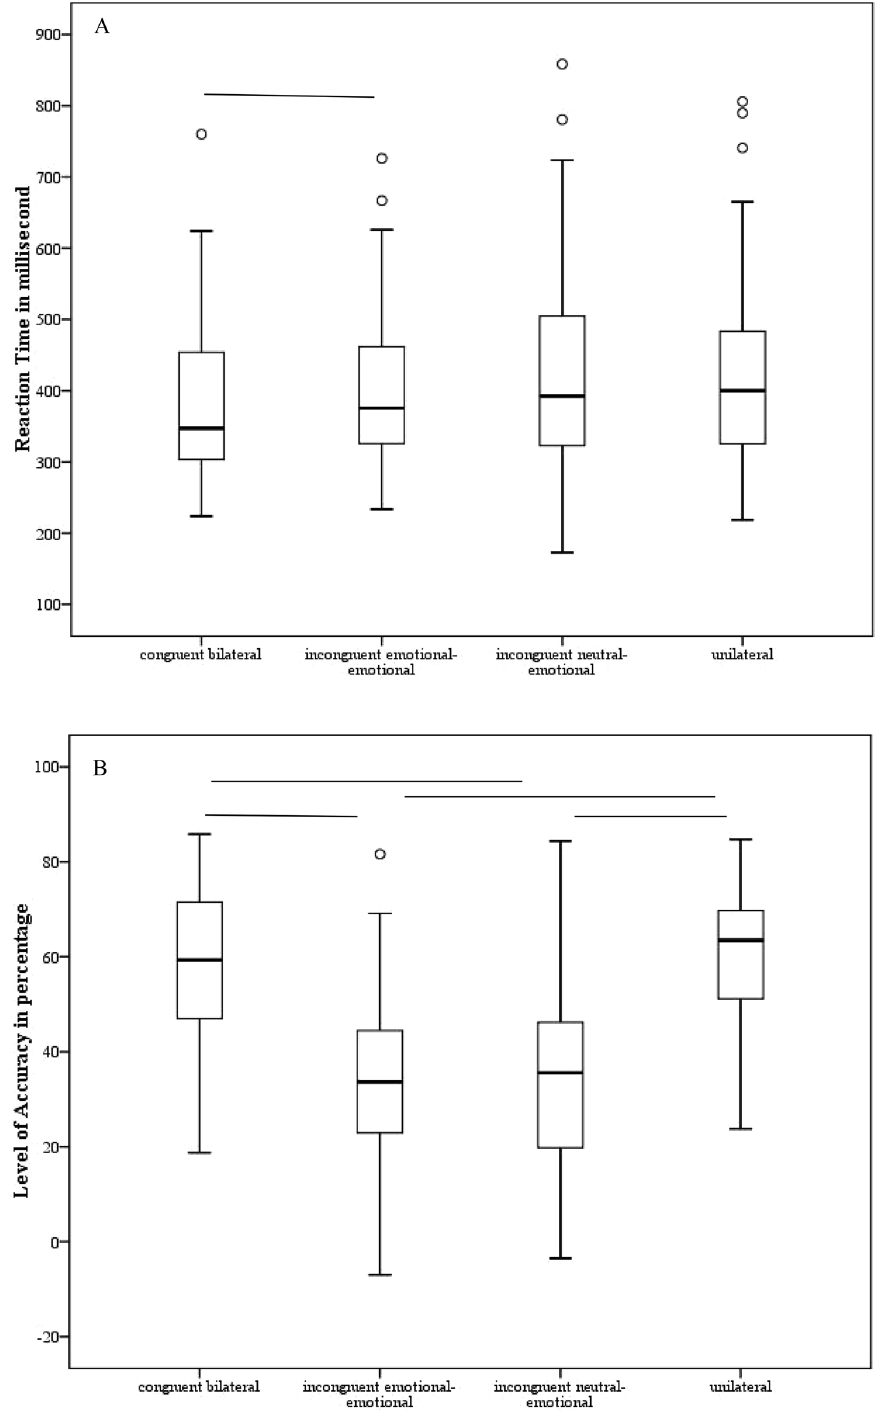
Figure 2. For each experimental condition (congruent bilateral, incongruent emotional-emotional, incongruent neutral-emotional congruent, unilateral; x-axis), the mean relative to the reaction time expressed in milliseconds ( A ) on the y-axis (left panels) and the level of accuracy ( B ) expressed in percentage on the y-axis (right panels) are depicted, when the emotion of fear was tested. The minimum, the lower quartile, the median, the upper quartile, the maximum, and the outliers are shown. Horizontal lines denote significant differences at p <